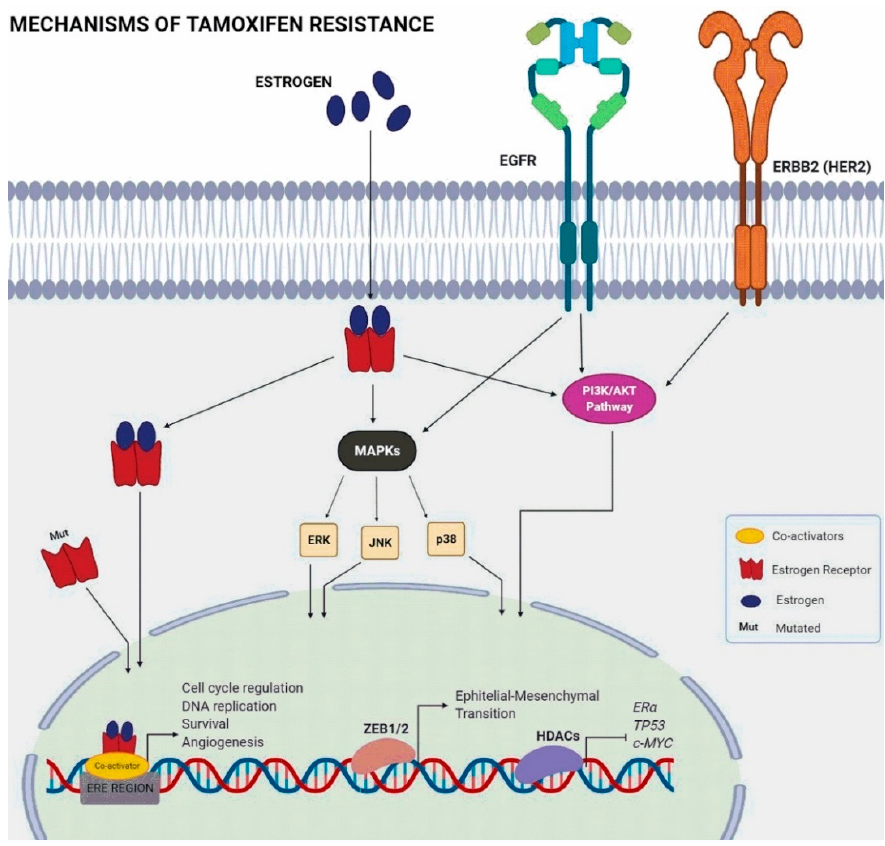
Figure 1. Estrogen signaling and pathways that interfere in tamoxifen resistance.